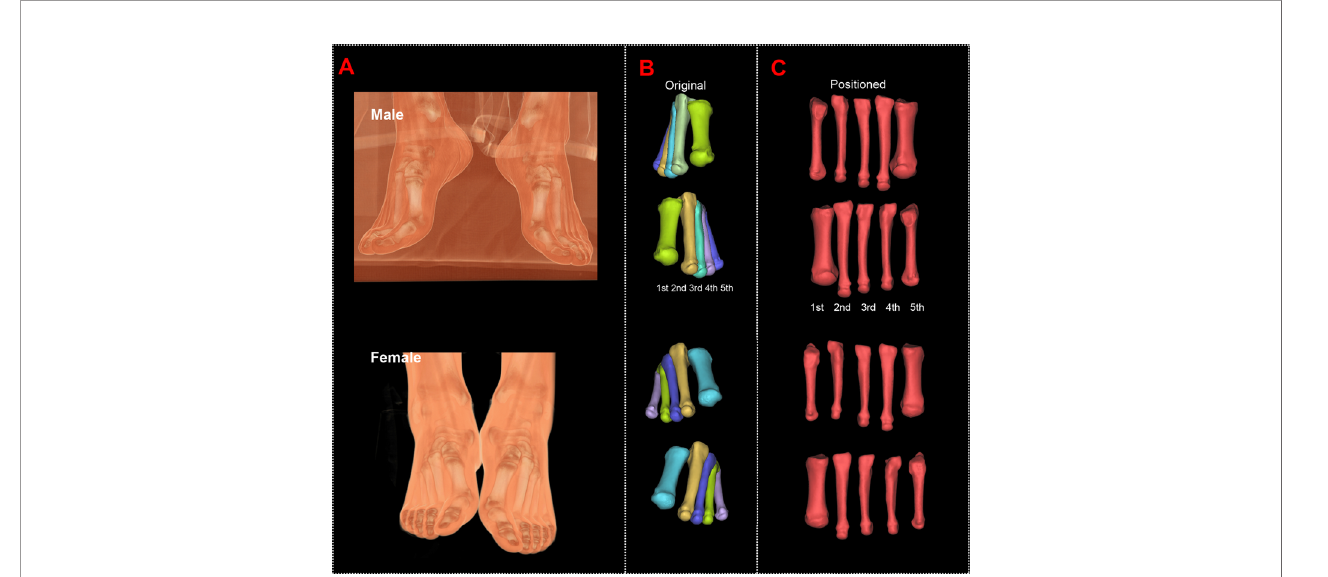
FIGURE 1 | Computed tomography reconstructions of the original and positioned scanning posture of the investigated metatarsal bones. (A) Scanning postures of a male and a female subject. (B) Reconstructed fi rst to fi fth metatarsal bones of the male and female subjects. (C) Positioned fi rst to fi fth metatarsal bones of the male and female